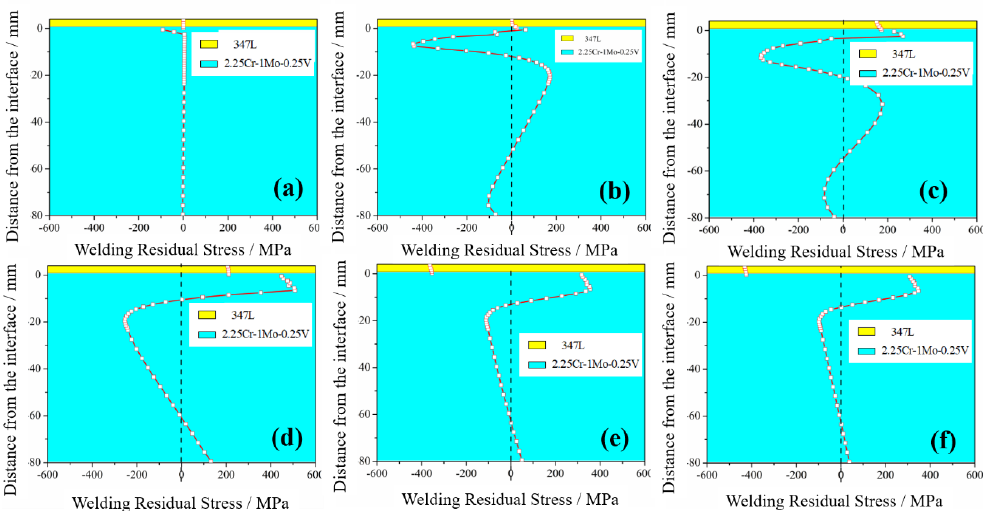
Figure 14. WRS distribution in cladding/substrate system for different cooling times: ( a ) 0.001 s, ( b ) 2.5 s, ( c ) 11.24 s, ( d ) 154 s, ( e ) 1004 s, and ( f ) 4000 s.